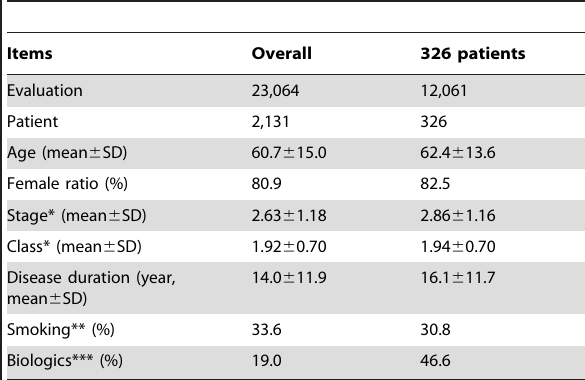
Table 1. Basic characteristics of the subjects in the current